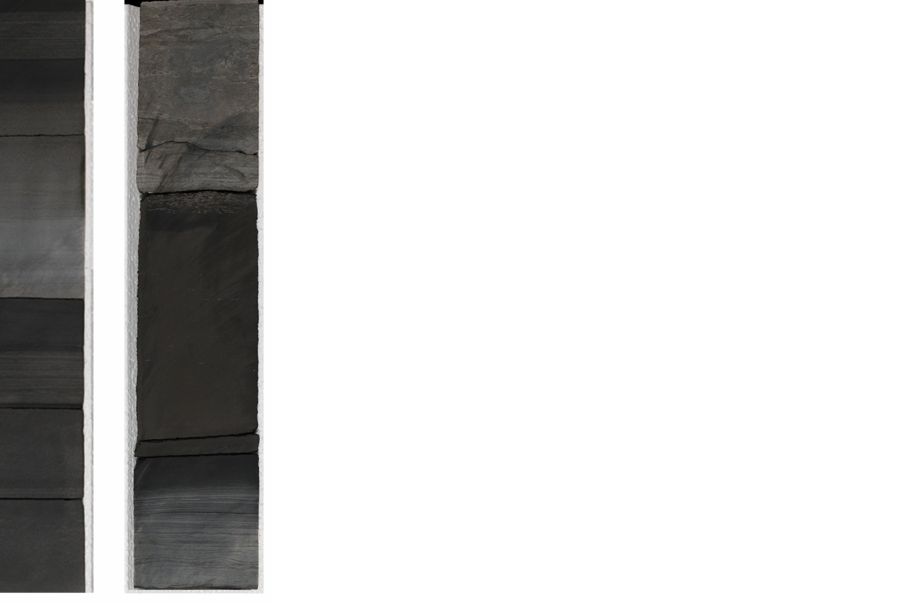
Figure 14. Core sample photo from the Wolfcamp cored interval. Sample length for each is 1.2